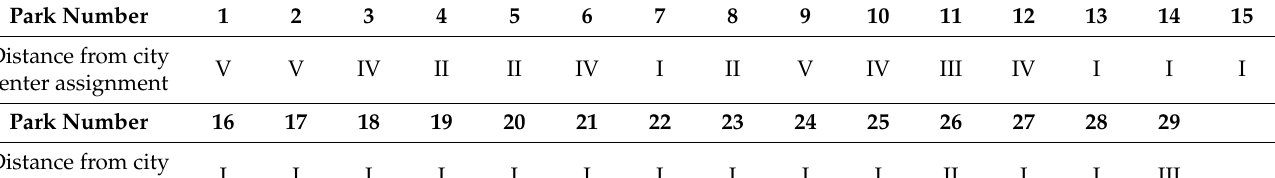
Table 13. The results of distance assignment of country parks from city center.